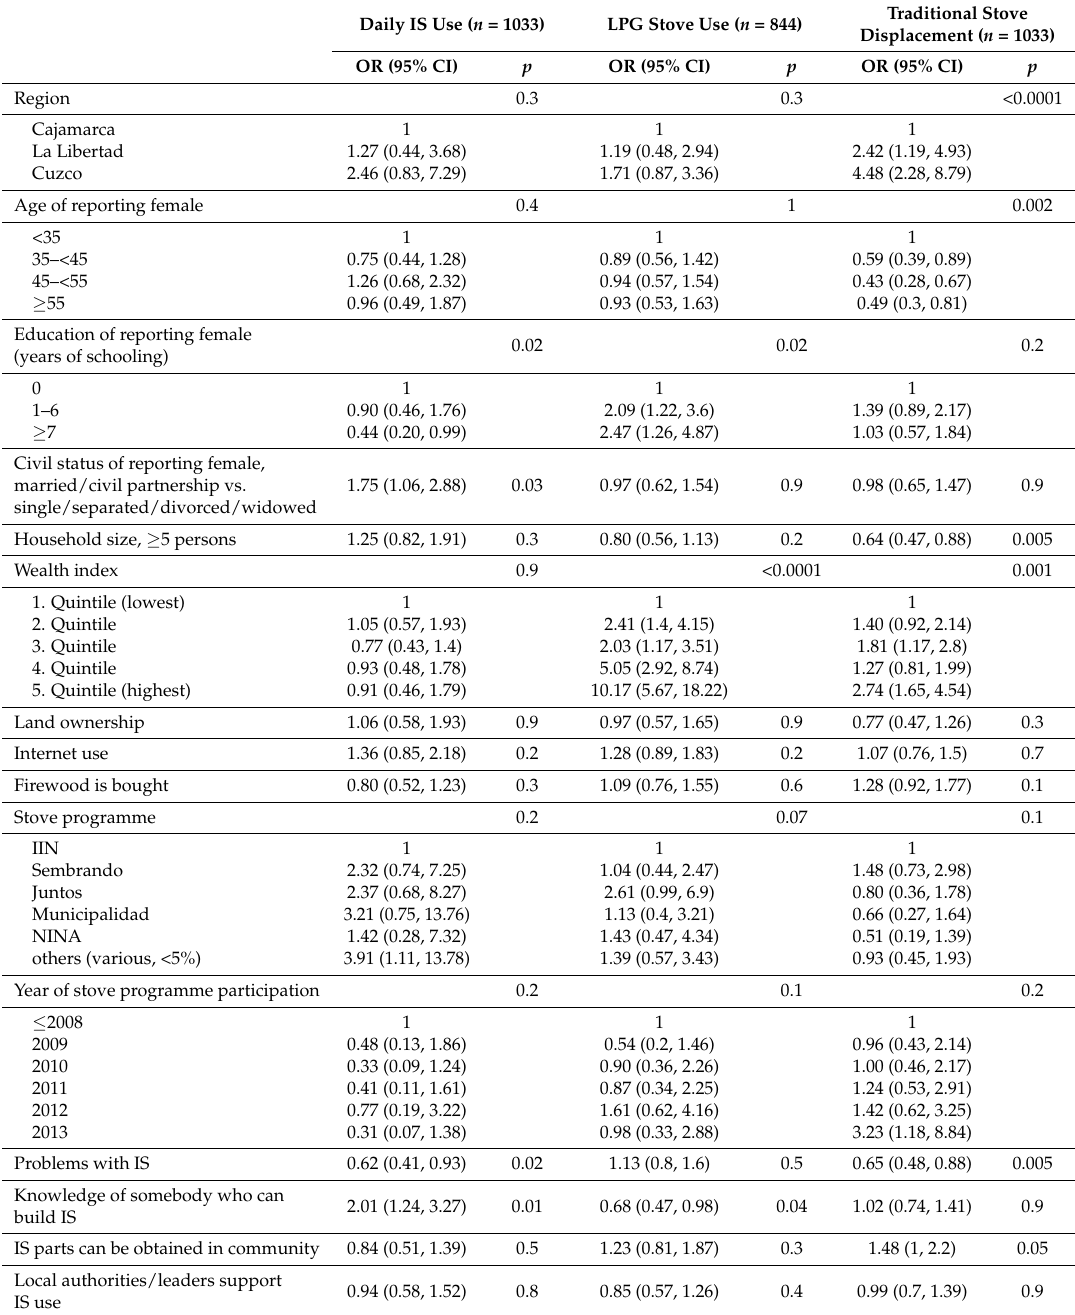
Table 2. Results of multivariable logistic regression analysis of daily IS use, LPG stove use and traditional stove displacement, Peru